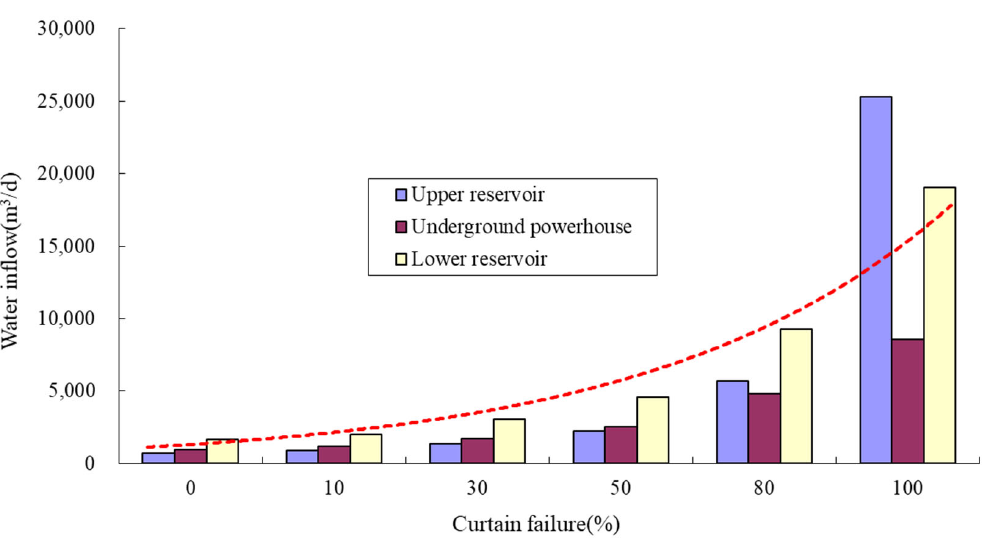
Figure 11. Relationships between water flow of the upper, lower storage reservoirs and power ‐ with the change of the curtain houses with the change of the curtain failure.